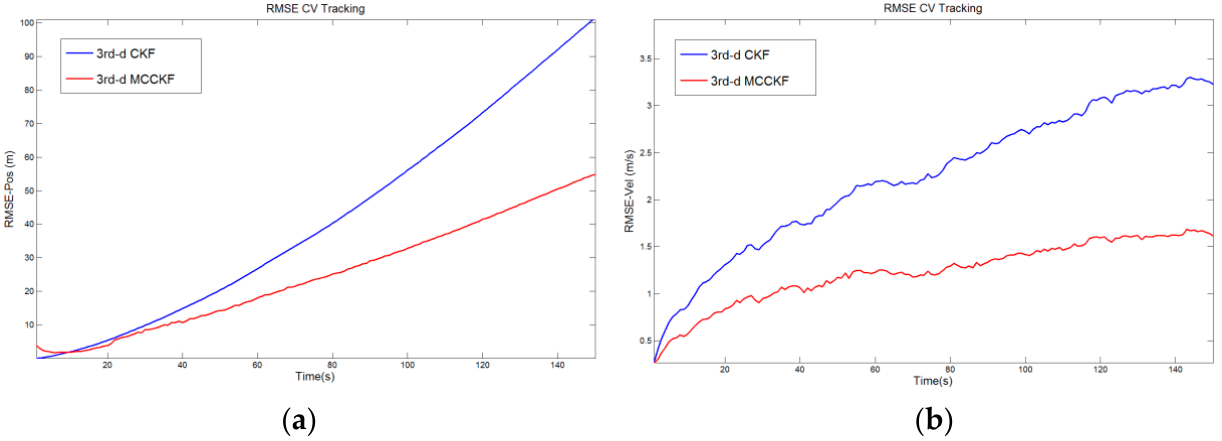
Figure 3. RMSE of the position and velocity for different filters under non-Gaussian noise condi- tions in Equation (61) ((a) is the position RMSE and (b) is the velocity RMSE).